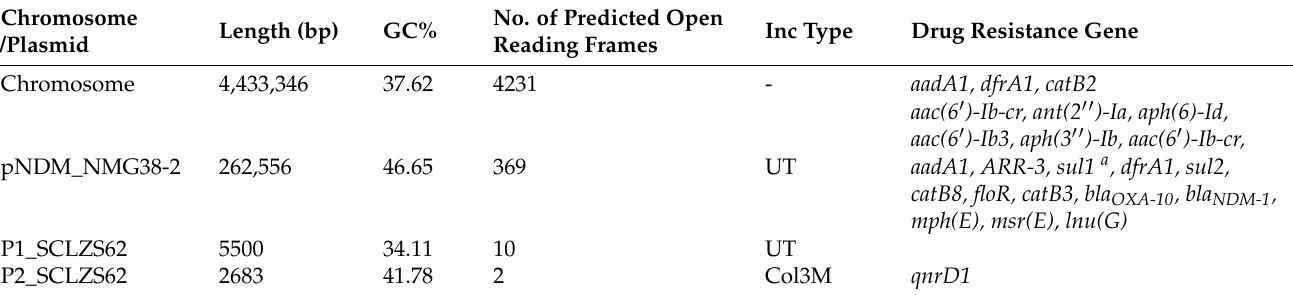
Table 2. Summary of the genetic features of Proteus sp.